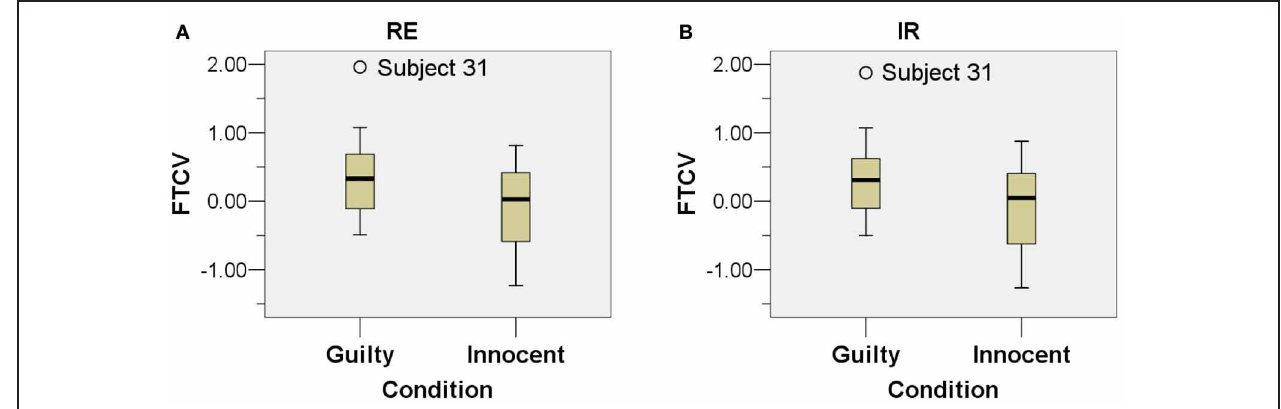
FIGURE 6 | Boxplots of the two types of questions. (A) relevant sub-questions and (B) irrelevant sub-questions. The X-axis indicates the condition (Guilty Condition and Innocent Condition) and the Y-axis indicates the facial temperature change value in degrees Celsius ( ◦ C).